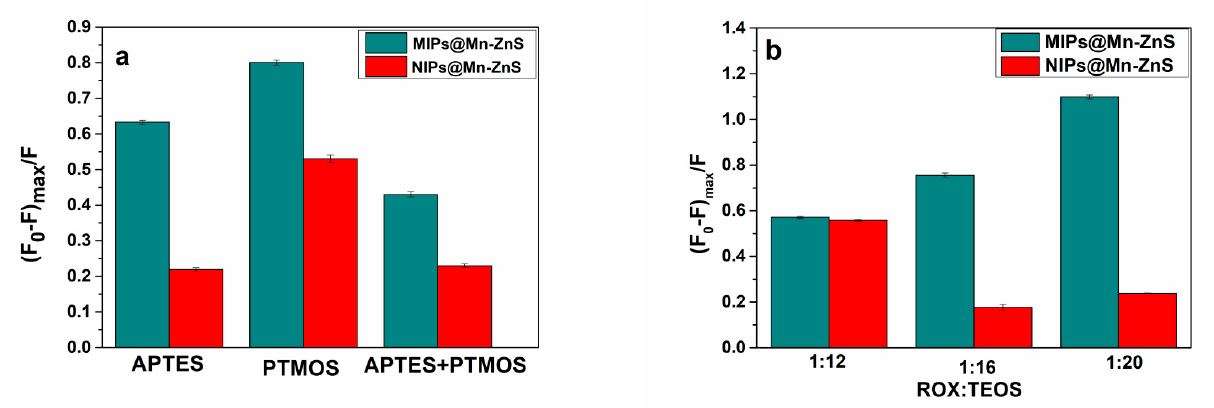
Figure 2. The effect of the different type of functional monomer ( a ), and the molar ratio of cross-linker (TEOS) ( b ) on the fluorescence intensity of MIPs@Mn-ZnS QDs towards ROX. ROX to cross-linker (TEOS) ( b ) on the fluorescence intensity of MIPs@Mn-ZnS QDs to- wards ROX. The amount of cross-linking agent played a significant part in the imprinting